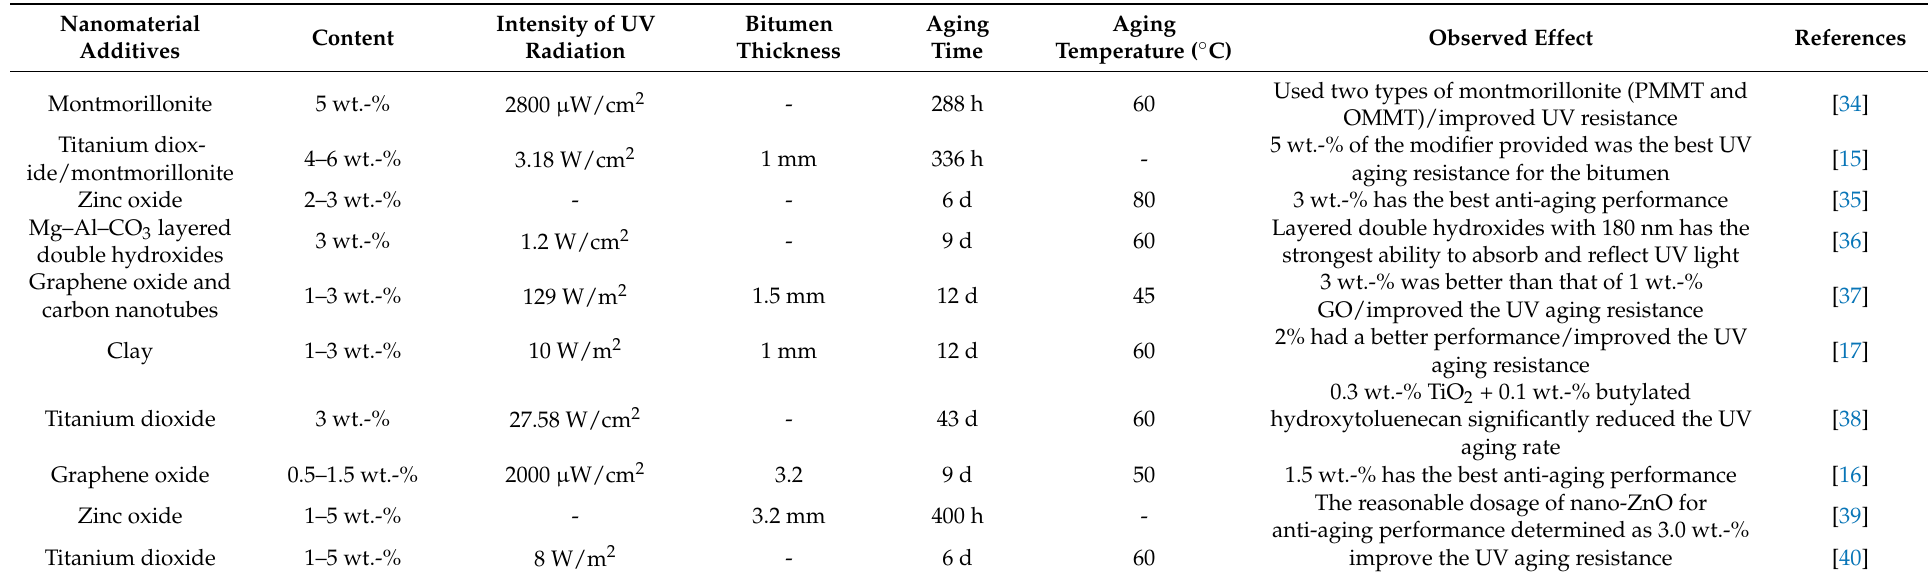
Table 1. Effects of UV aging on nanomaterial additives, as observed by various